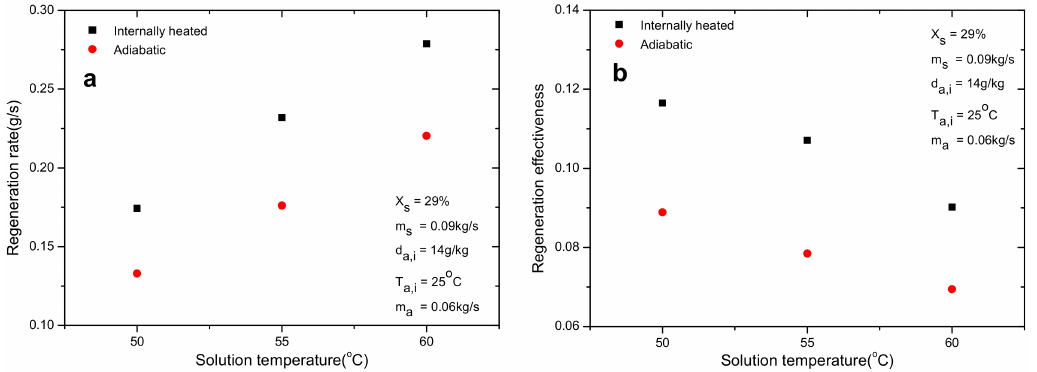
Figure 11. Effect of solution temperature on regeneration performance: ( a ) regeneration rate; ( b ) regeneration effectiveness.